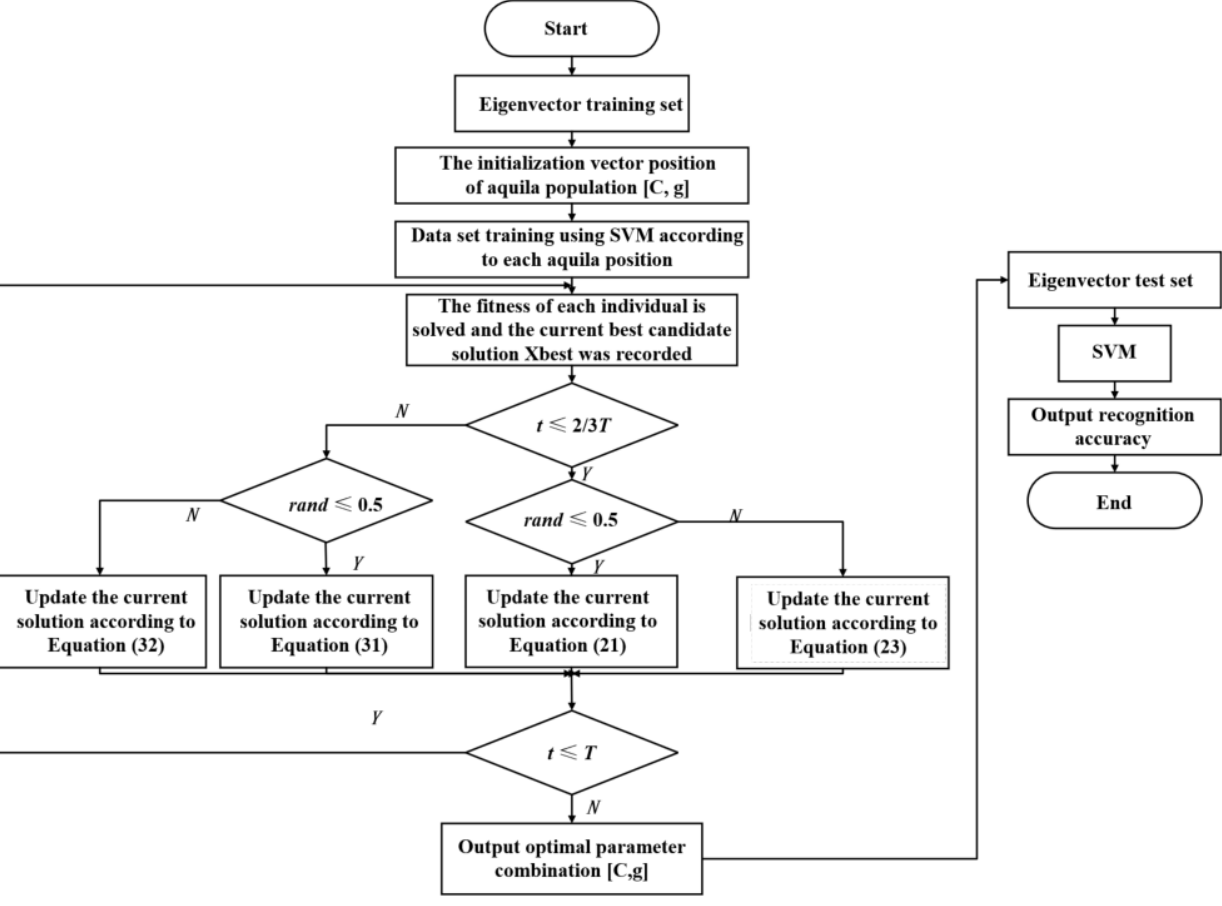
Figure 12. The flowchart of SVM improved by AO algorithm.